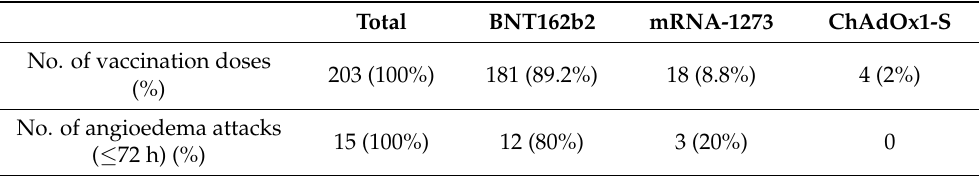
Table 5. No. and type of intramuscularly delivered vaccines as second doses and no. of angioedema attacks following the vaccination ( ≤ 72 h).